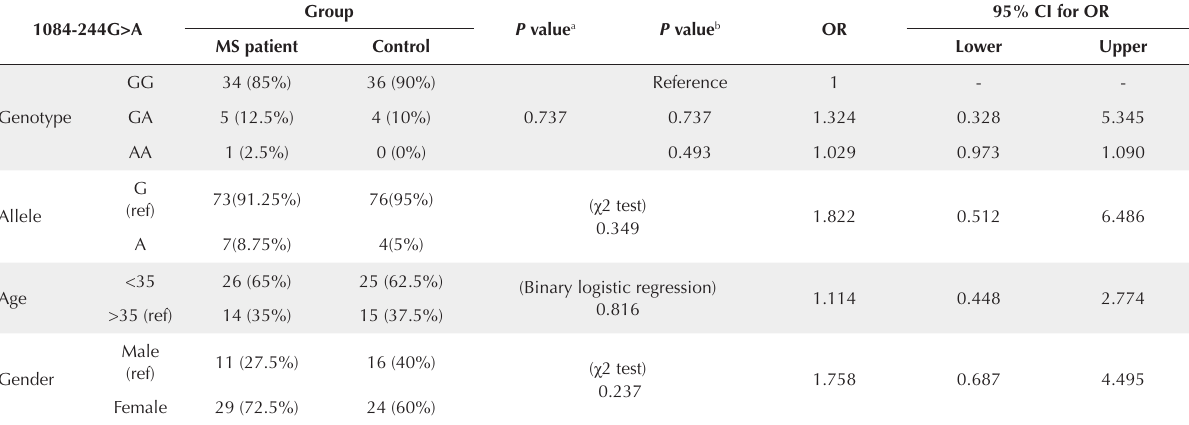
Table 1. Allele distribution, genotype frequency, and statistical analysis of NEFH rs3815335 polymorphism among RRMS patients versus control group